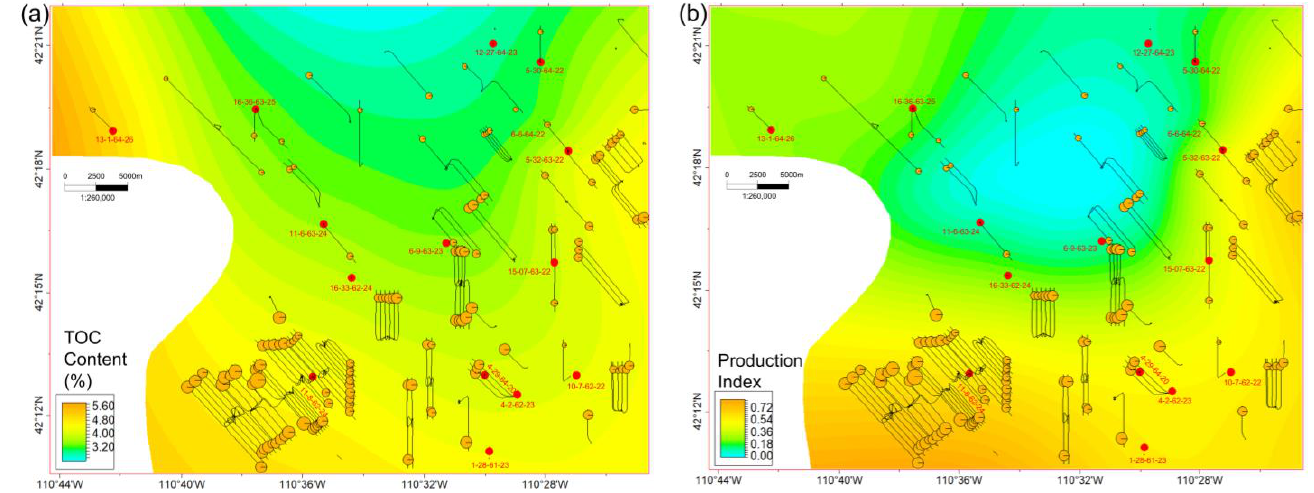
Figure 11. Geochemistry features in the examined region. ( a ) Map view of total organic carbon (TOC, wt%). ( b ) Map view of Production Index (PI). The grey circle represents the one-year gas production equivalence per stage for horizontal wells, scaled by production values.